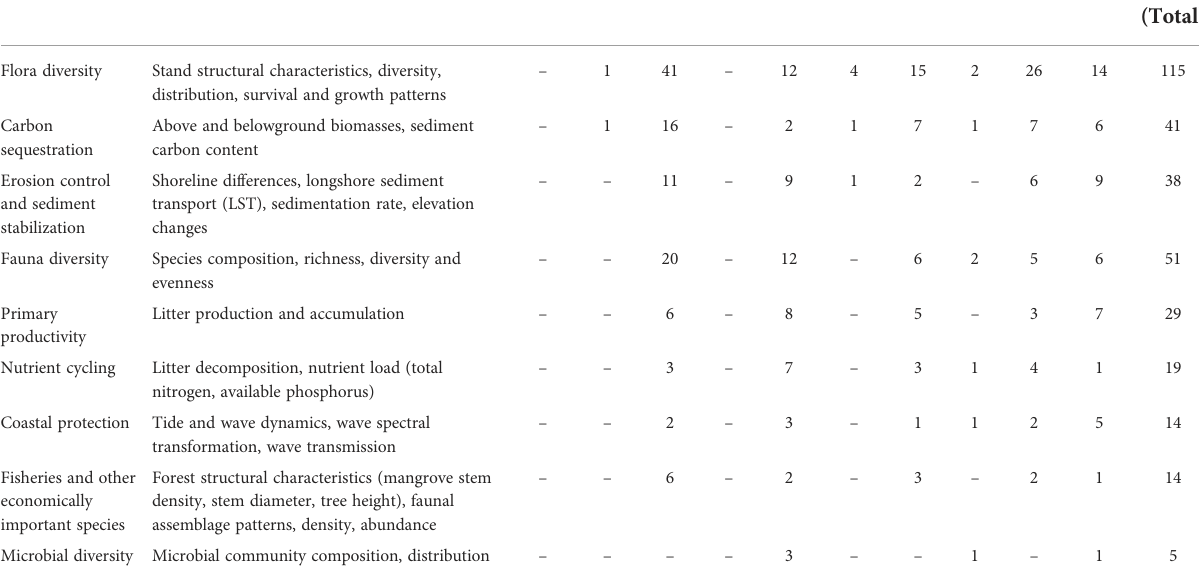
TABLE 5 Ecological functions assessed on mangrove restoration studies from each country and in SE